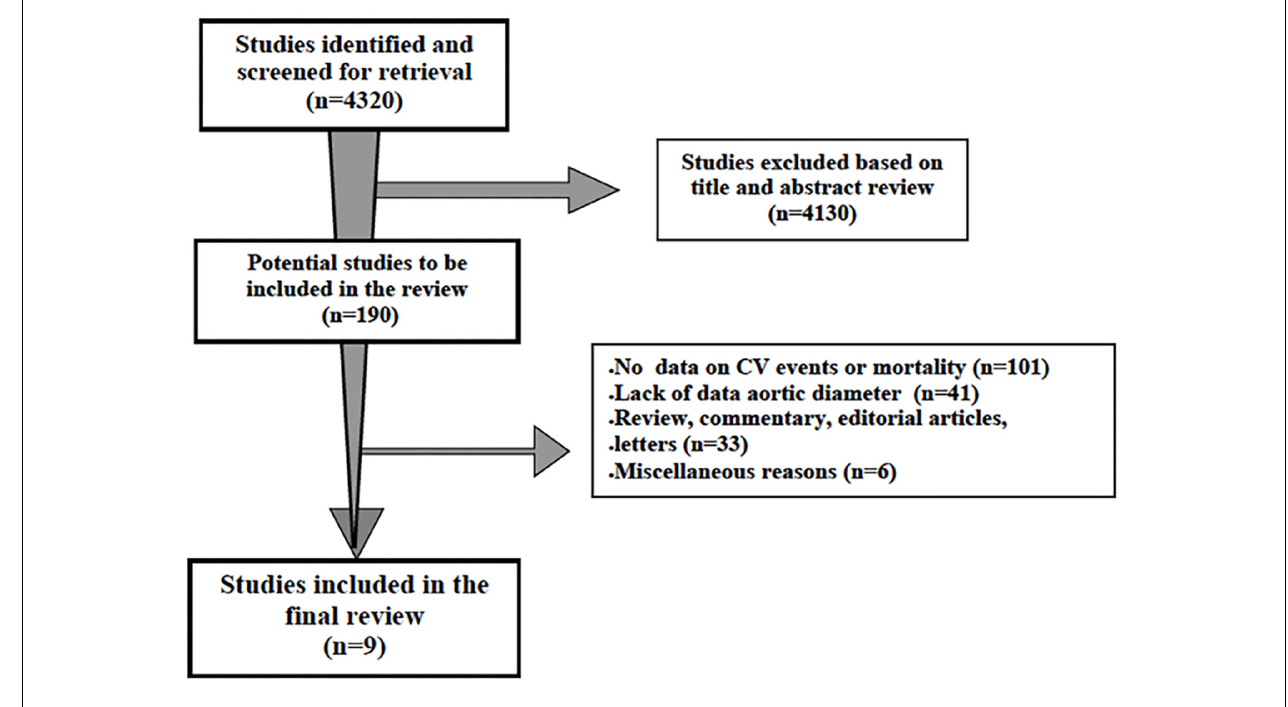
FIGURE 1 | Schematic flowchart for the selection of